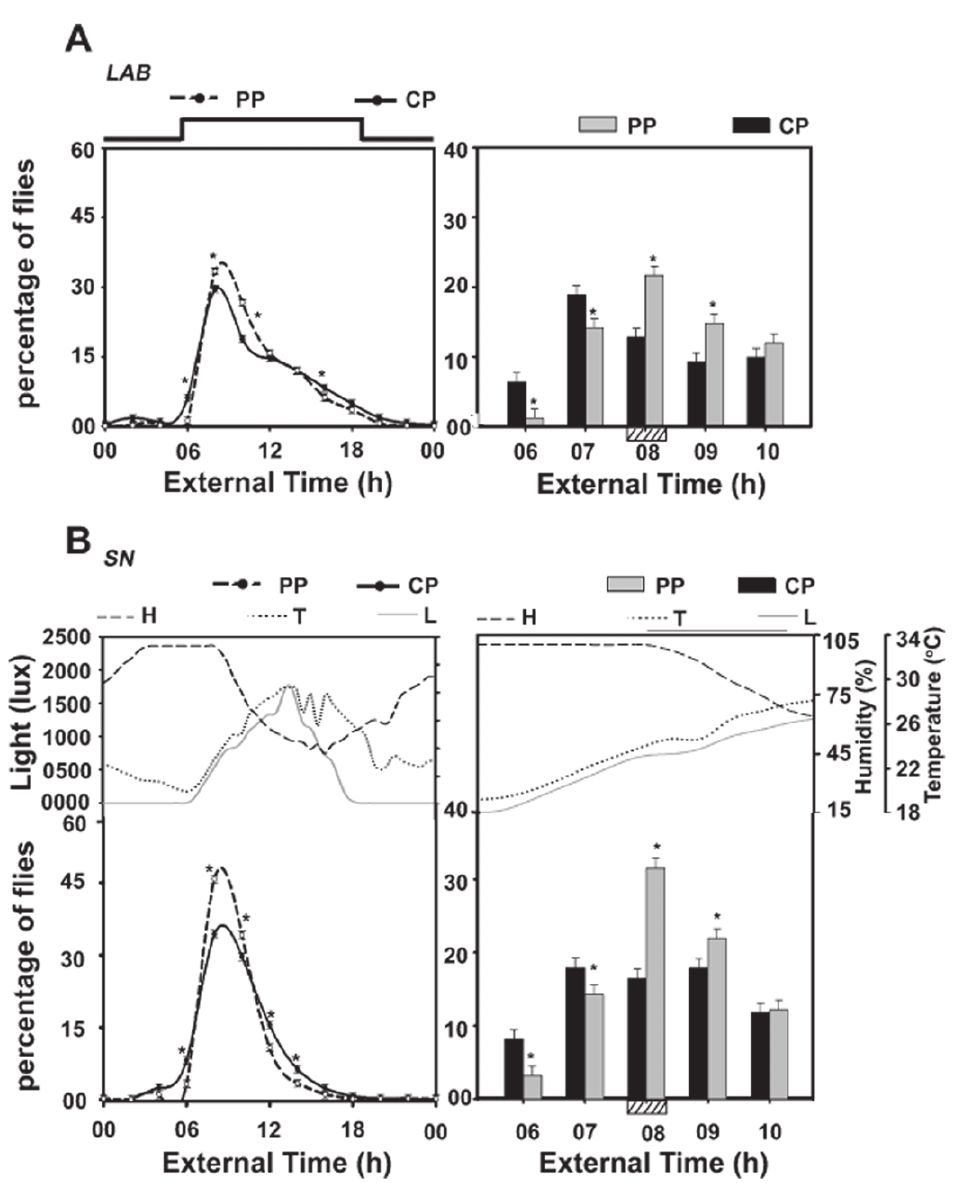
Figure 2. Enhanced stability in adult emergence of selected population persists under semi-natural (SN) condition. (A) Waveform of adult emergence (left panel) in selected ( PP ) and control ( CP ) populations averaged across five consecutive cycles under laboratory (LAB). Percentage of flies emerged in 2 h bins are plotted along y -axis and External Time in h along x -axis. The square wave line above the Figure represents 12:12 h light/dark (LD) cycles under laboratory condition. Peak of emergence in PP and CP populations under LAB (right panel). (B) Waveform of emergence (left panel) of PP and CP populations averaged across five consecutive cycles under SN. Peak of emergence in PP and CP populations under SN (right panel). Upper panels of 2B show average profiles of light (lux), temperature ( u C) and humidity (%RH) for the entire duration of the experiment. A greater percentage of PP flies emerge during the selection window compared to CP . Concurrent to the increase in percentage emergence during the selection window there is a decrease in percentage emergence prior-to the selection window, with reduced anticipation to lights-on. Shaded box on the x -axis represents the selection window. Under SN, PP flies sustain robust waveform of emergence with more prominent peak and narrower gate- width. Error bars represent 95% comparison intervals (95%CI) around the mean for visual hypothesis testing. For this assay, ten vials for each of the four replicate populations were used under each environmental condition. The mean values of four replicates and variance in terms of 95% comparison interval (95%CI) were used to draw emergence profiles and error bars. doi:10.1371/journal.pone.0050379.g002 p , 0.0001), E 6 P 6 T interaction ( F 11,33 = 152.3; p , 0.0001), while percentage of PP flies emerging during selection window, a de- crease prior-to (ExT6-7) and an increase after (ExT8-9), associated the effect of E ( F 1,3 = 0.8; p =0.4) and P was statistically not with reduced lights-on anticipatory emergence was observed under significant ( F 1,3 = 0.8; p = 0.4). Post-hoc multiple comparisons both conditions (ExT5-6; Figure 2A, B). ANOVA on emergence using Tukey’s test revealed that while under both conditions, data revealed a statistically significant effect of T ( F 11,33 = 416.4; percentage of PP flies emerging during selection window was p , 0.0001), E 6 T ( F 11,33 = 39.3; p , 0.0001), P 6 T ( F 11,33 = 185.8; significantly higher compared to CP , under SN, PP emerged in